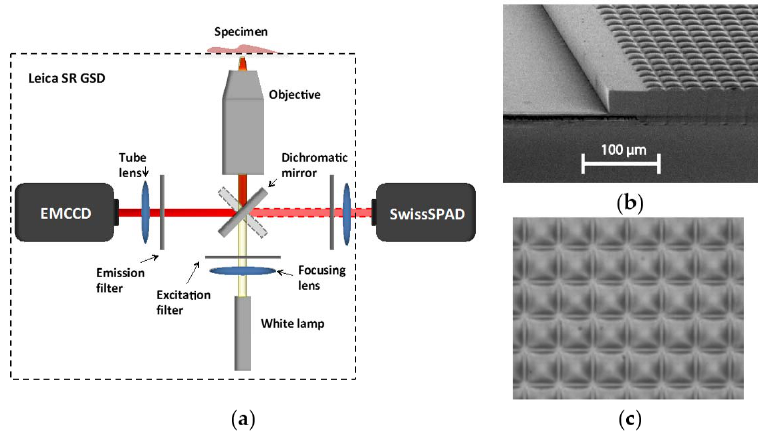
Figure 10. ( a ) Schematic microscope setup used in the imaging experiments based on the Leica SR GSD microscope (Leica Microsystems Wetzlar, Germany); ( b ) SEM scan of the microlens array deposited on the sensor; ( c ) Optical micrograph of the microlens array.